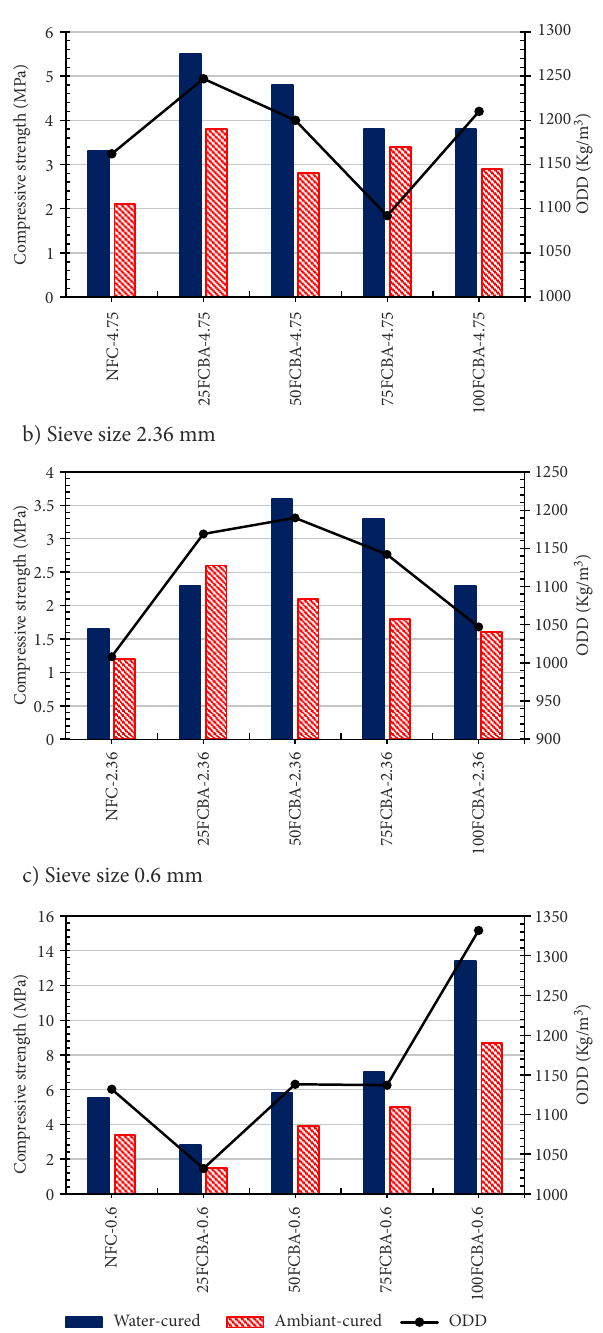
Figure 4. Relationship of the compressive strength and oven-dry density of LFC specimens